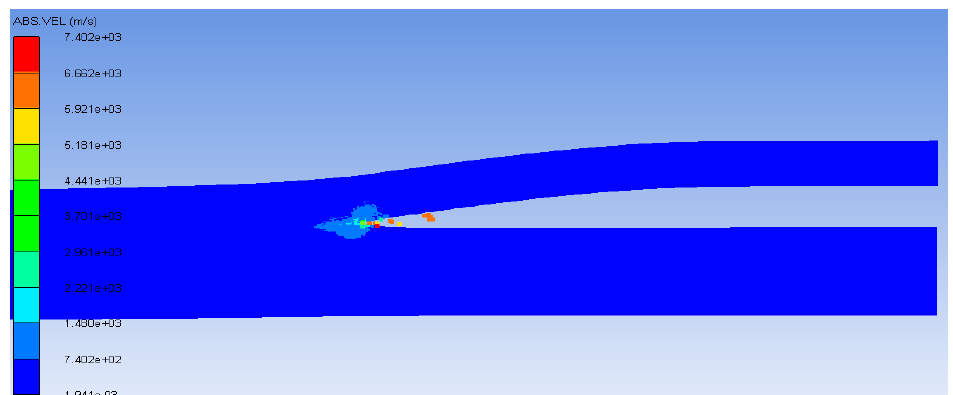
Figure 4. The contour of the velocity distribution.